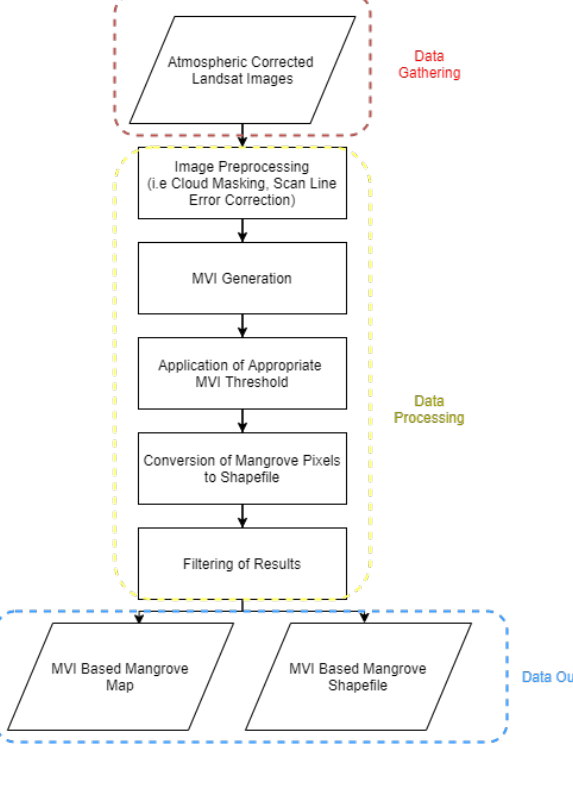
Figure 3. General